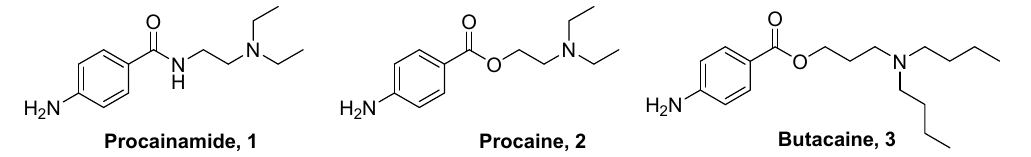
Figure 1. Structures of the target APIs: procainamide ( 1 ), procaine ( 2 ) and butacaine ( 3 ).